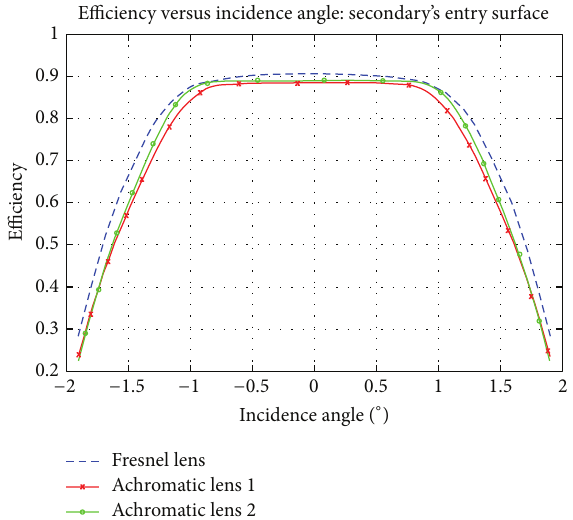
Figure 8: Pondered efficiency for whole spectra (ASTM 1) of solar light at different incidence angles.